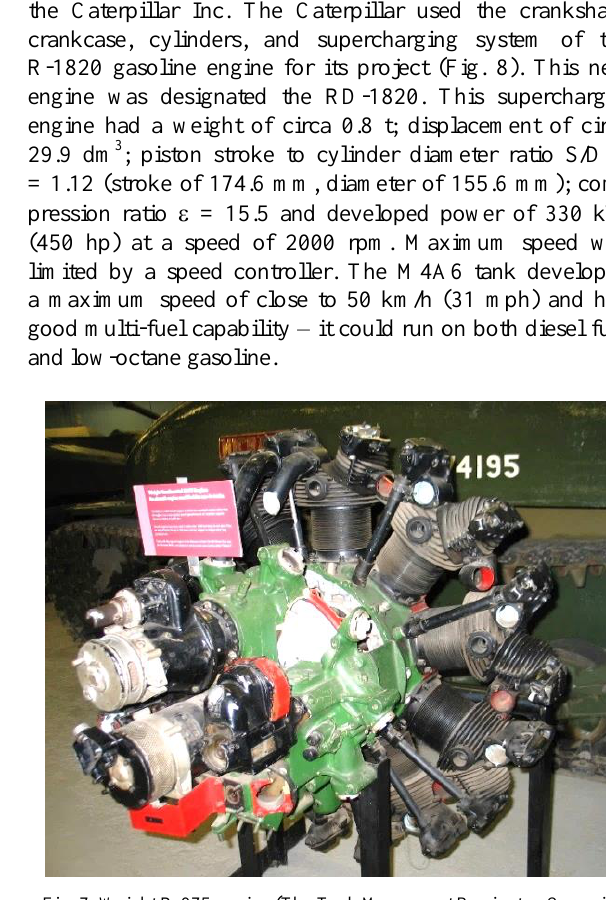
Dorset, photo by the author)